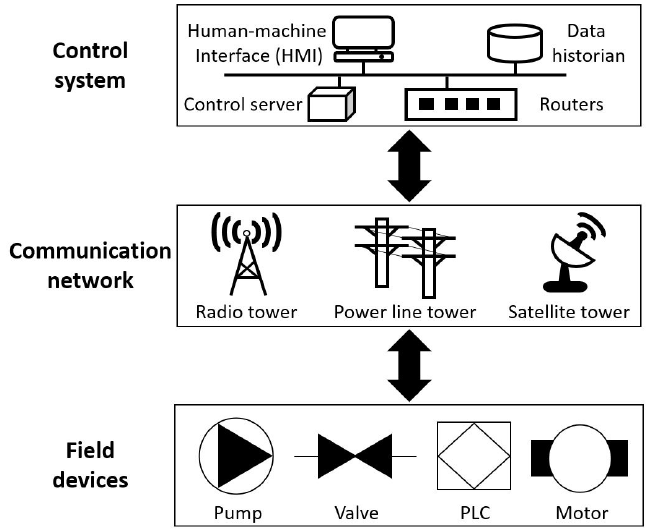
Figure 1. Illustration of ICS